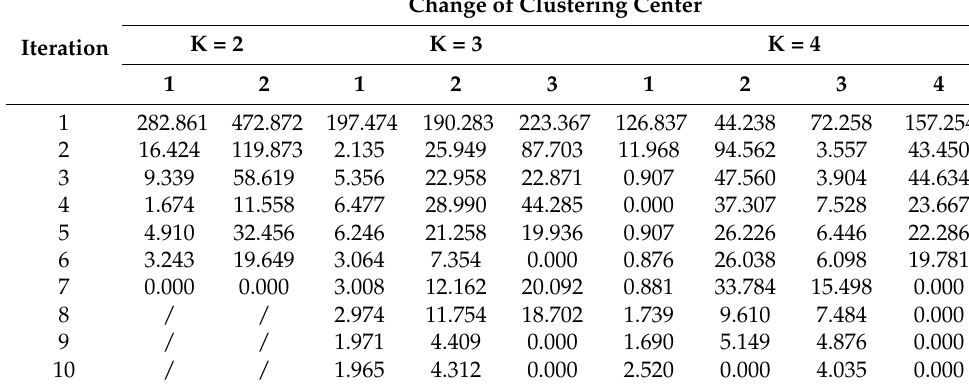
Table 2. Iterative